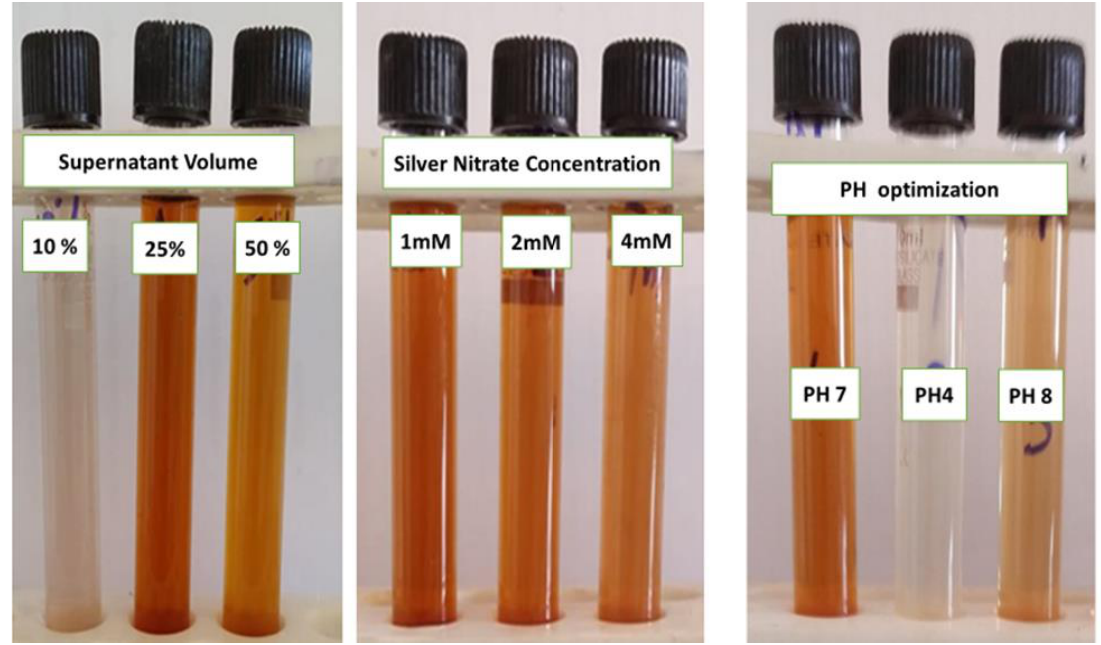
Figure 5. Optimization of nano particles synthesis was done by changing the volume of supernatant, silver nitrate concentration and changing final mixture PH.